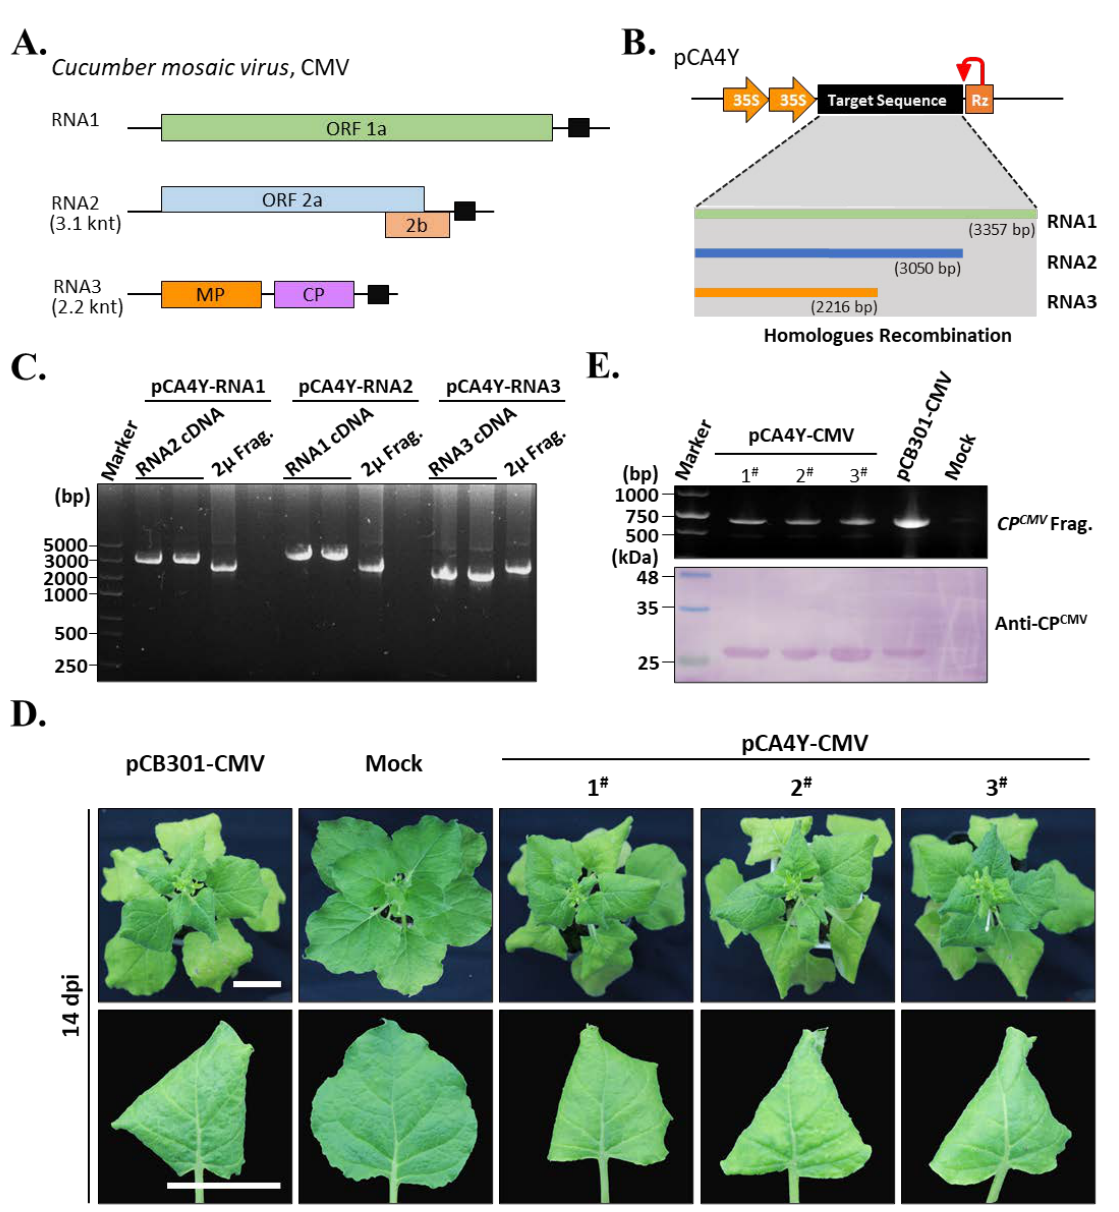
Figure 3. Construction of the Cucumber mosaic virus (CMV-Fny) infectious cDNA clone using the established triple-shutting vector-based yeast HR recombination. ( A ). Genome organization of the CMV-Fny. ORF1 and ORF2 are associated together and formed the viral replicase. 2b is a classical viral encoded gene silencing suppressor. RNA3 encodes the movement protein (MP) and coat protein (CP). ( B ). Illustration of the detailed construction strategies for three cDNAs that correspond to the CMV-Fny genomic RNAs. ( C ). PCR validation of the positive CMV-Fny infectious cDNA clones with specific pairs of primers listed in Supplementary Table S1. 2 μ Frag. was the short name of the yeast 2 μ replication origin and the TRP1 autotrophic marker gene fragment. ( D ). Symptoms of the CMV-Fny infectious cDNA clones-inoculated Nicotiana benthamiana plants after 14 dpi. The pCB301-CMV-Fny-inoculated plants were treated as the positive control, and the blank agrobacterium-infiltrated plants were served as mock. Numbers 1 # , 2 # , and 3 # represent the three independent inoculated plants. Bar indicates 3 cm. ( E ). RT-PCR and Western blot detect the infectivity of the newly constructed CMV-Fny infectious clones. Specific pairs of primers amplification of the CP coding region or the CP-specific antibodies were used in RT-PCR and Western blot, respectively.